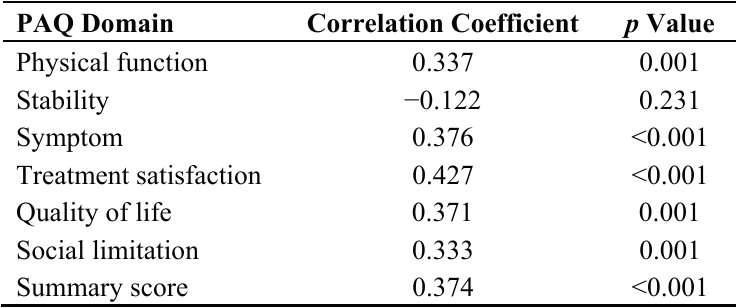
Table 4. Correlation between scores of each PAQ domain and ABI after